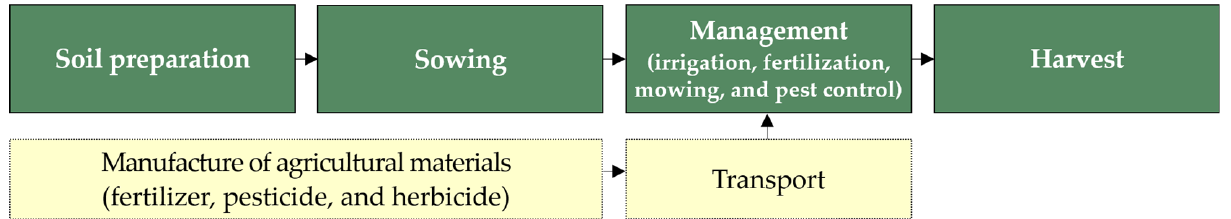
Figure 3. Overview of landscape tree production process.